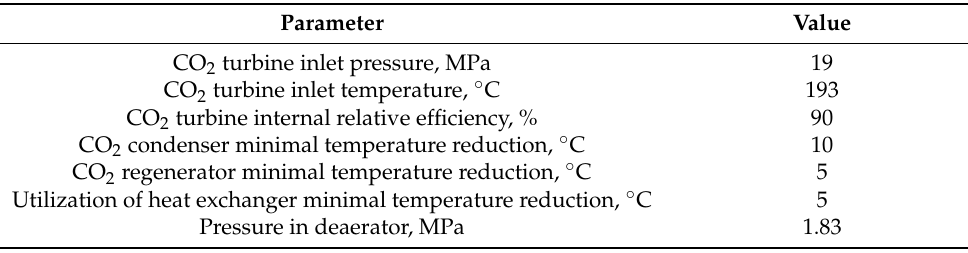
Table 5. Simulation input data for Case 2b.